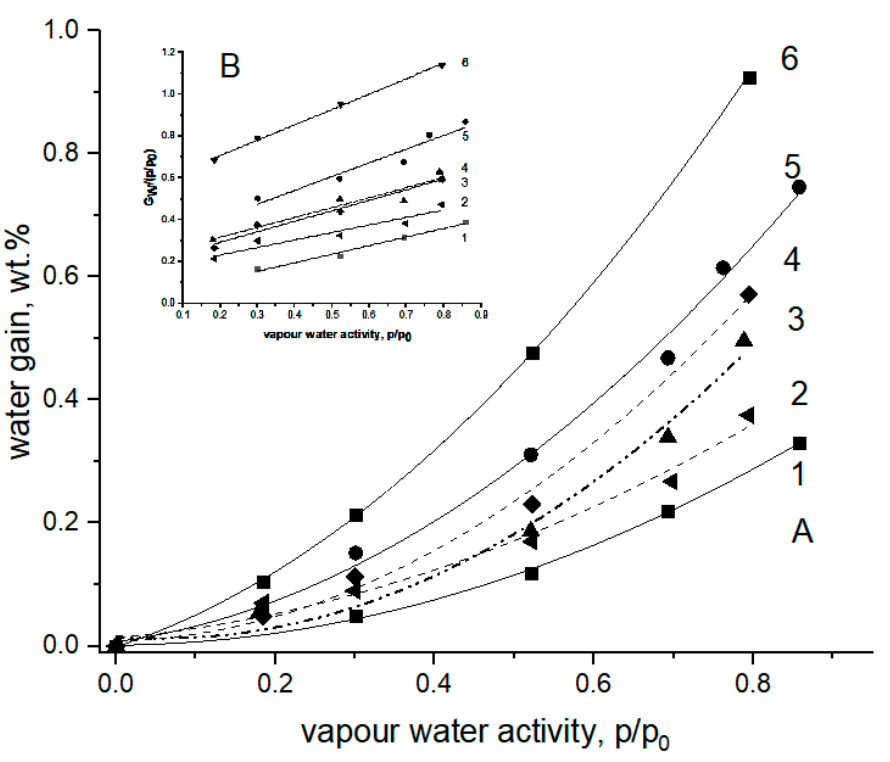
Figure 1. The isotherms of moisture absorption for pristine PHB and PLA fibers and their fibrillar blends at 25 °C [36]. ( A ) The PHB/PLA weight ratios: 1—100/0 (PHB), 2—70/30, 3—50/50, 4—30/70, 5—10/90, 6—0/100 (PLA). ( B ) Linearization of experimental data (points) by the polynomial equation—Equation (1).